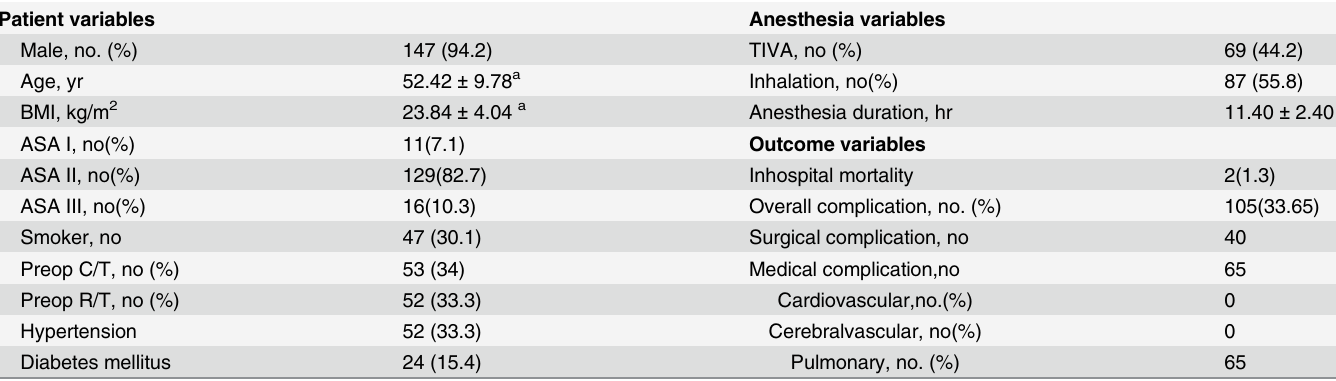
Table 1. Clinical and demographic characteristics(Total patients =